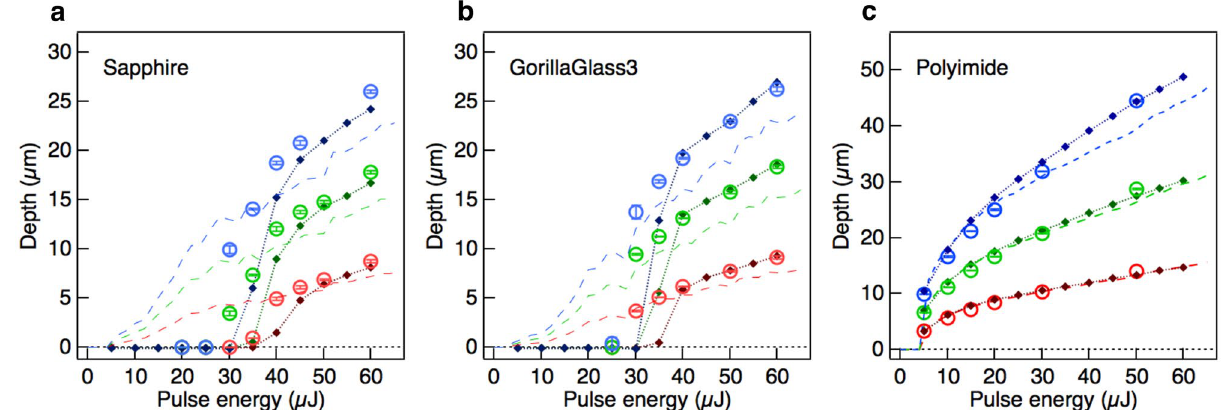
Figure 4. Comparison between experiments and simulations for various materials. Averaged ablated depths along the circular trajectory from the simulation (open circles) and the experiment (filled diamonds) are plotted as a function of the pulse energy. The radius of the circular irradiation is 20 mm. Intact initial surfaces were irradiated using 100 (red), 200 (green), or 300 (blue) pulses. The error bars for the experimental results were calculated using the standard deviation from three independent measurements. Dashed lines represent the calculation reproduced from the arithmetic mean of the ablated depth over the training datasets for each of the pulse energies (see “Methods” Section). ( a ), Sapphire. ( b ) Chemically strengthened glass (Corning Gorilla Glass 3). ( c )